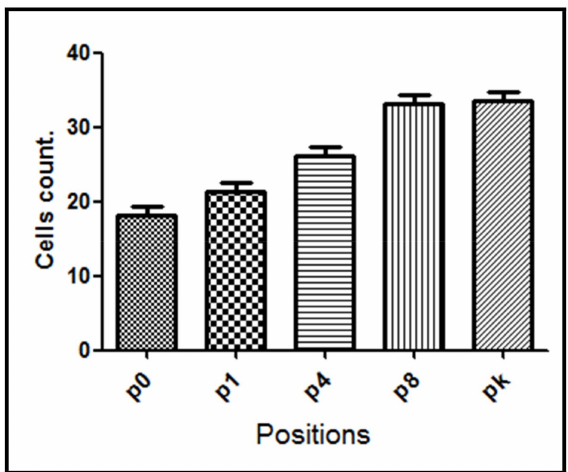
Figure 8. NF- κ B positive cell count for the G4 group evaluated at different positions from the bone lesion. The mean number with the corresponding standard deviation is shown for each